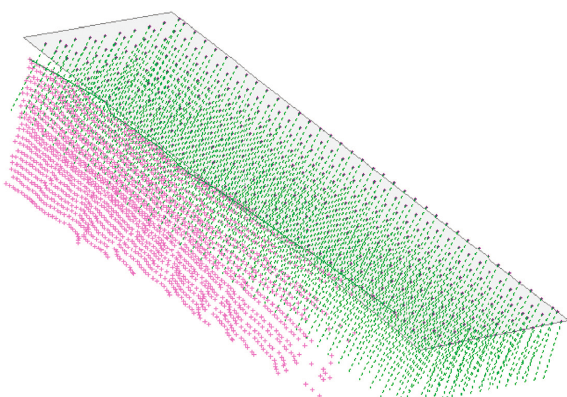
Figure 2: 3D display of the geological